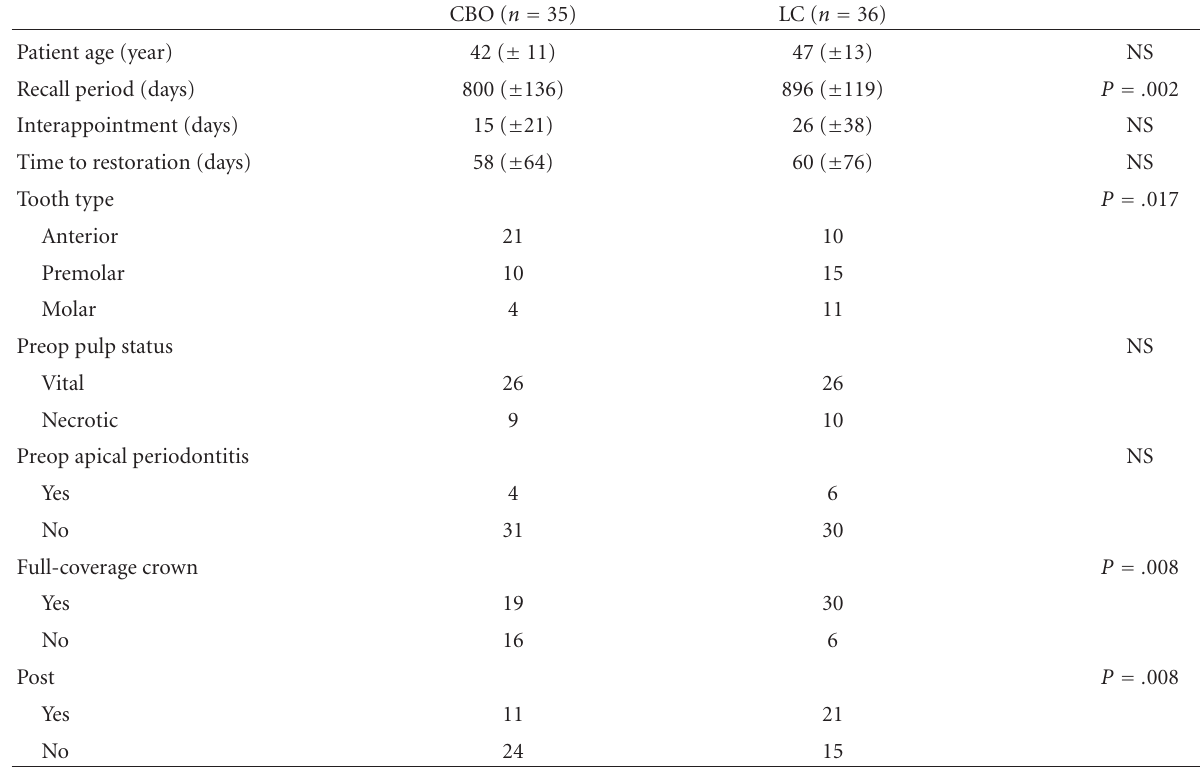
Table 1: Distribution of independent variables among